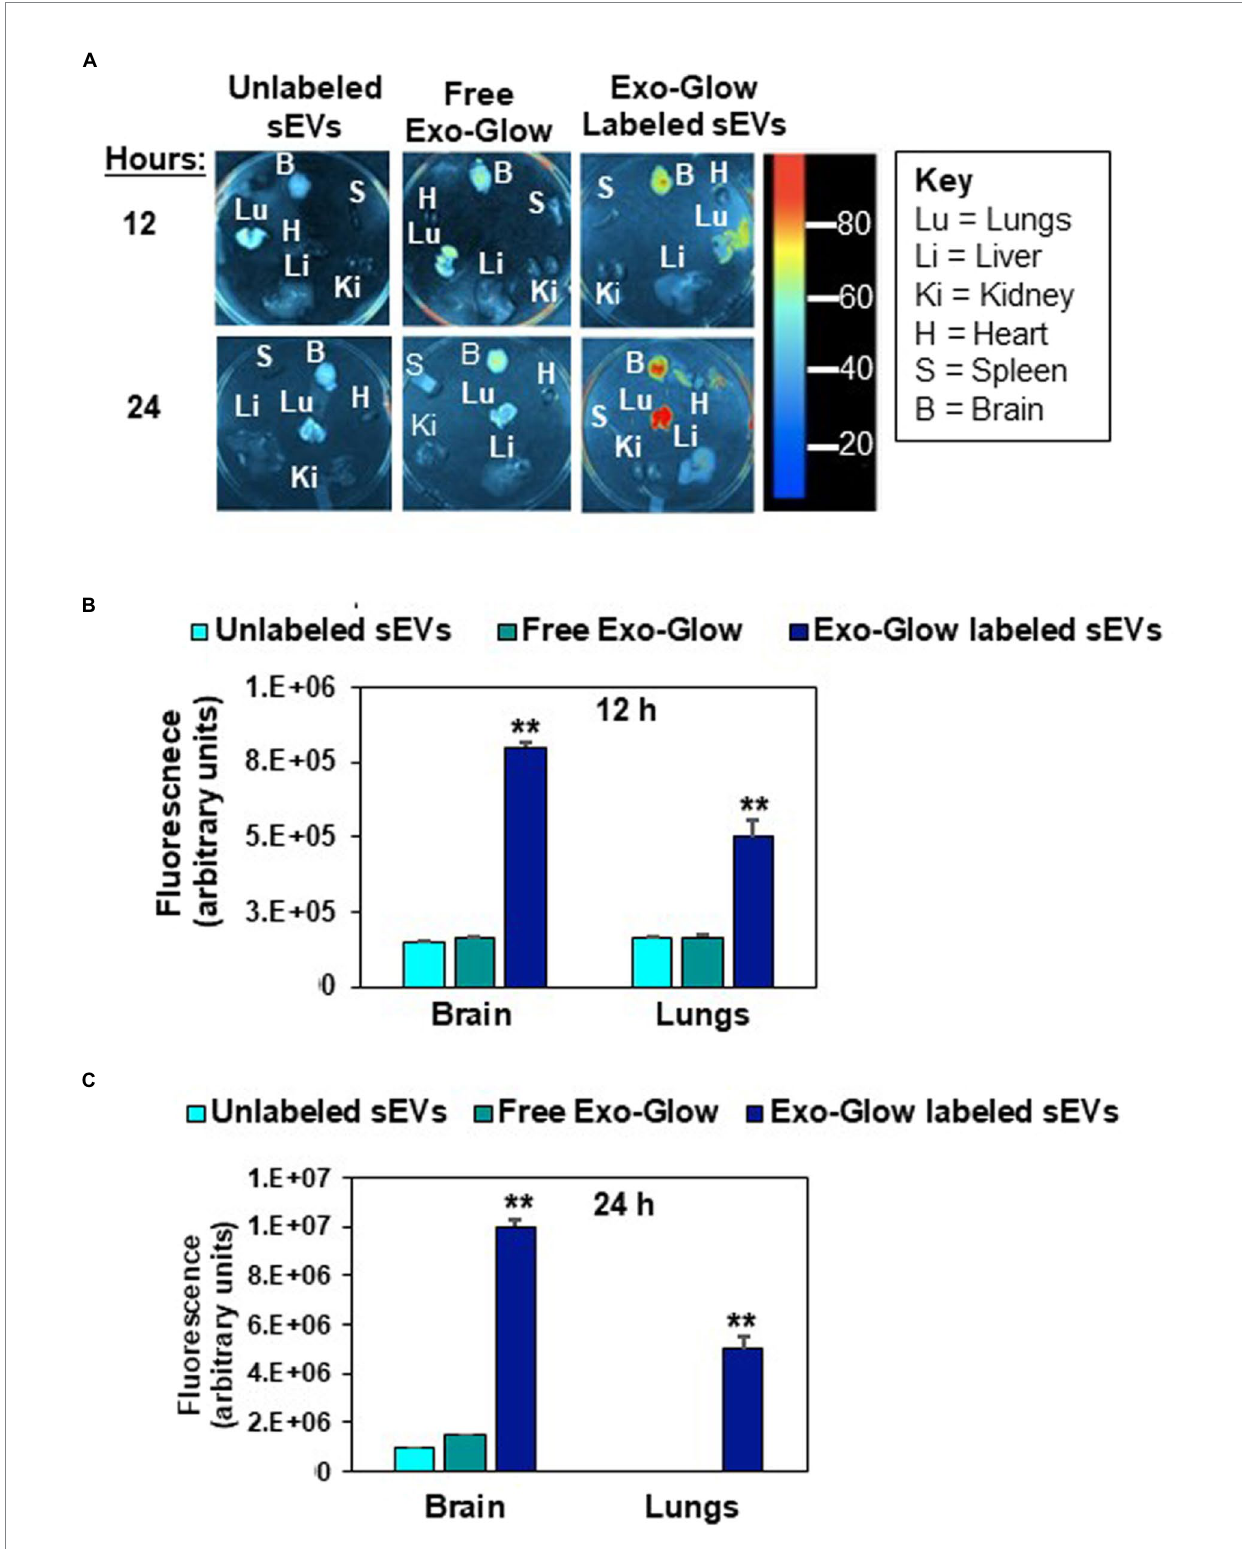
FIGURE 4 Distribution of Exo-Glow labeled small extracellular vesicles (sEVs) in C57BL/6 J mice. Free Exo-Glow, unlabeled egg sEVs and Exo-Glow labeled sEVs were administered by oral gavage. Mice were euthanized 12 h and 24 h after oral administration of sEVs (A) . Densitometry analysis of background- normalized fluorescence in brain and lungs 12 h (B) and 24 h (C) after oral gavage. Data were normalized by using the fluorescence from tissue-free sections in the dish. Values are mean ± SEM ( n = 3). Data were analyzed by Mann–Whitney U test (**Value of p <